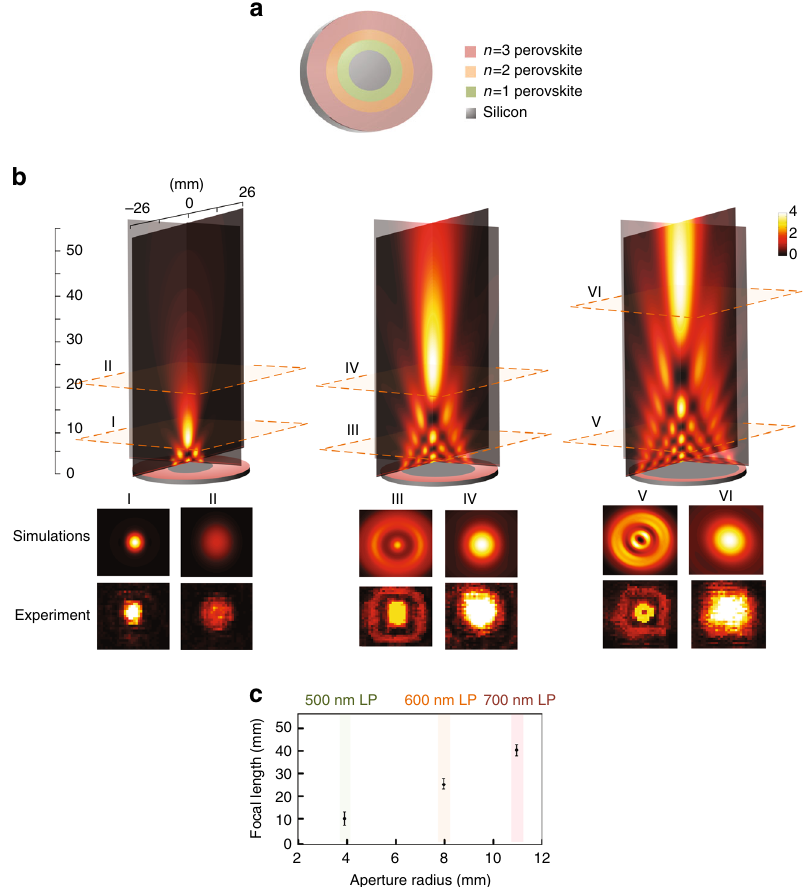
Fig. 6 Excitation tunable THz focusing element. a Sample schematic, where concentric rings of n = 1, 2, 3 perovskite fi lms were deposited such that upon selective excitation, the structure allows change of dielectric (unexcited) aperture size in metallic (photoexcited) rings; b (left to right) The FDTD simulation results for the focused rays through the different apertures (4, 8, and 11 mm). Panels I – VI show experimental THz images measured at positions of cross-sectional planes as denoted, as well as the corresponding cross-sections from numerical simulations. c The aperture radius and focal length at 500 nm long pass, 600nm long pass, and 700 nm long pass excitation. Error bars, s.d. for repeated measurements (eight in